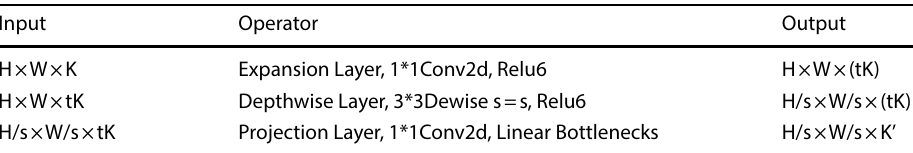
Table 3 Implementation process of